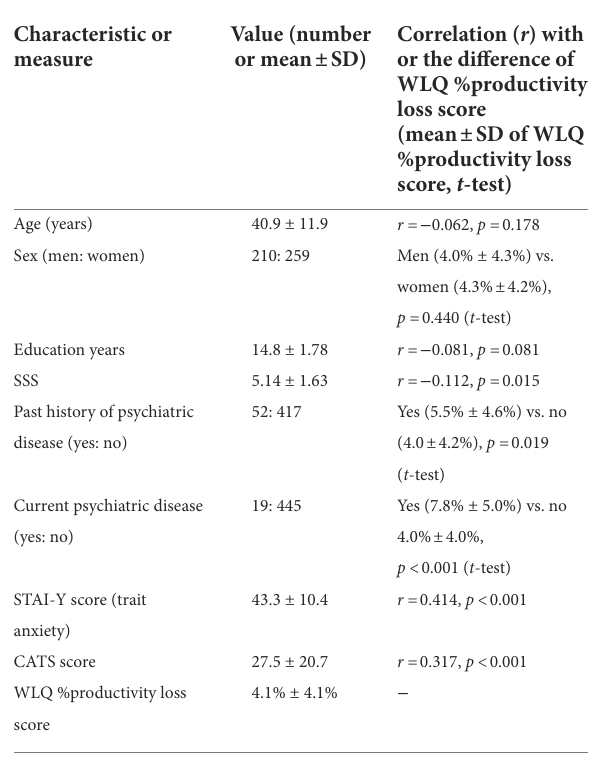
Value (number Correlation ( r ) with or mean ± SD) or the difference of WLQ %productivity loss score (mean ± SD of WLQ %productivity loss